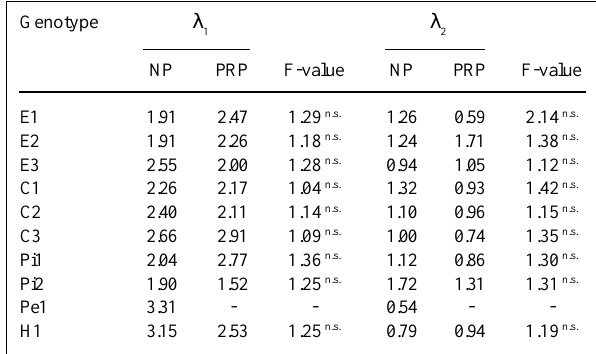
Table VI - Eigenvalues ( l ) of principal component 1 and principal component 2 by genotype within group of different Lycopersicon species and F-values for the homogeneity of variance